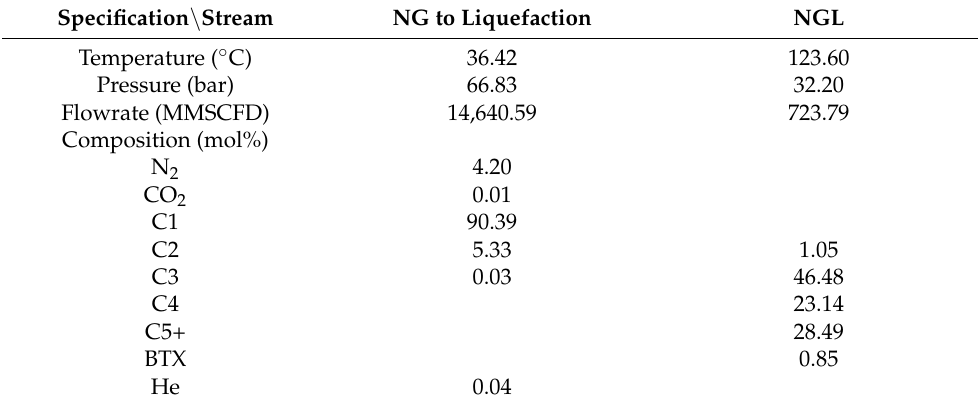
Table 7. NGL recovery unit conditions and specifications.